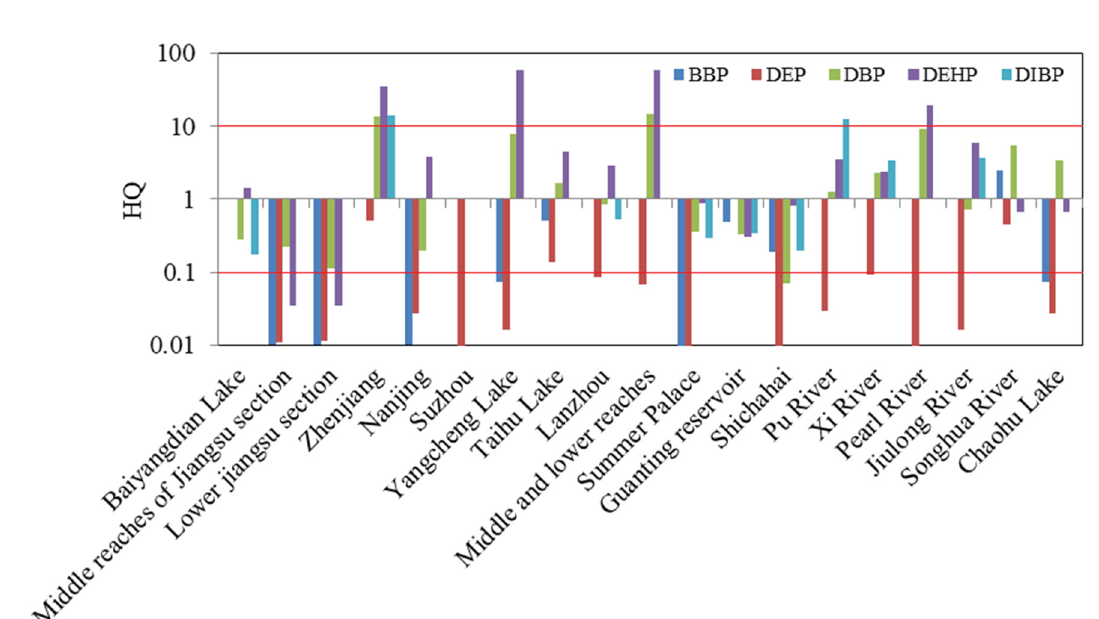
Figure 5. The preliminary ecological risks of ∑ 5 PAEs in typical rivers in China (in water ) .